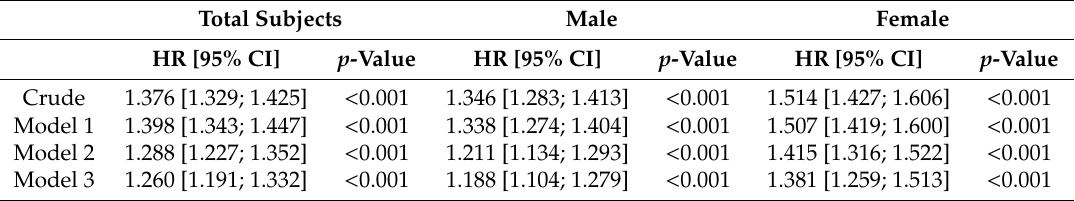
Table 2. Hazard ratio of serum uric acid for major adverse renal event with Cox proportional hazard models by